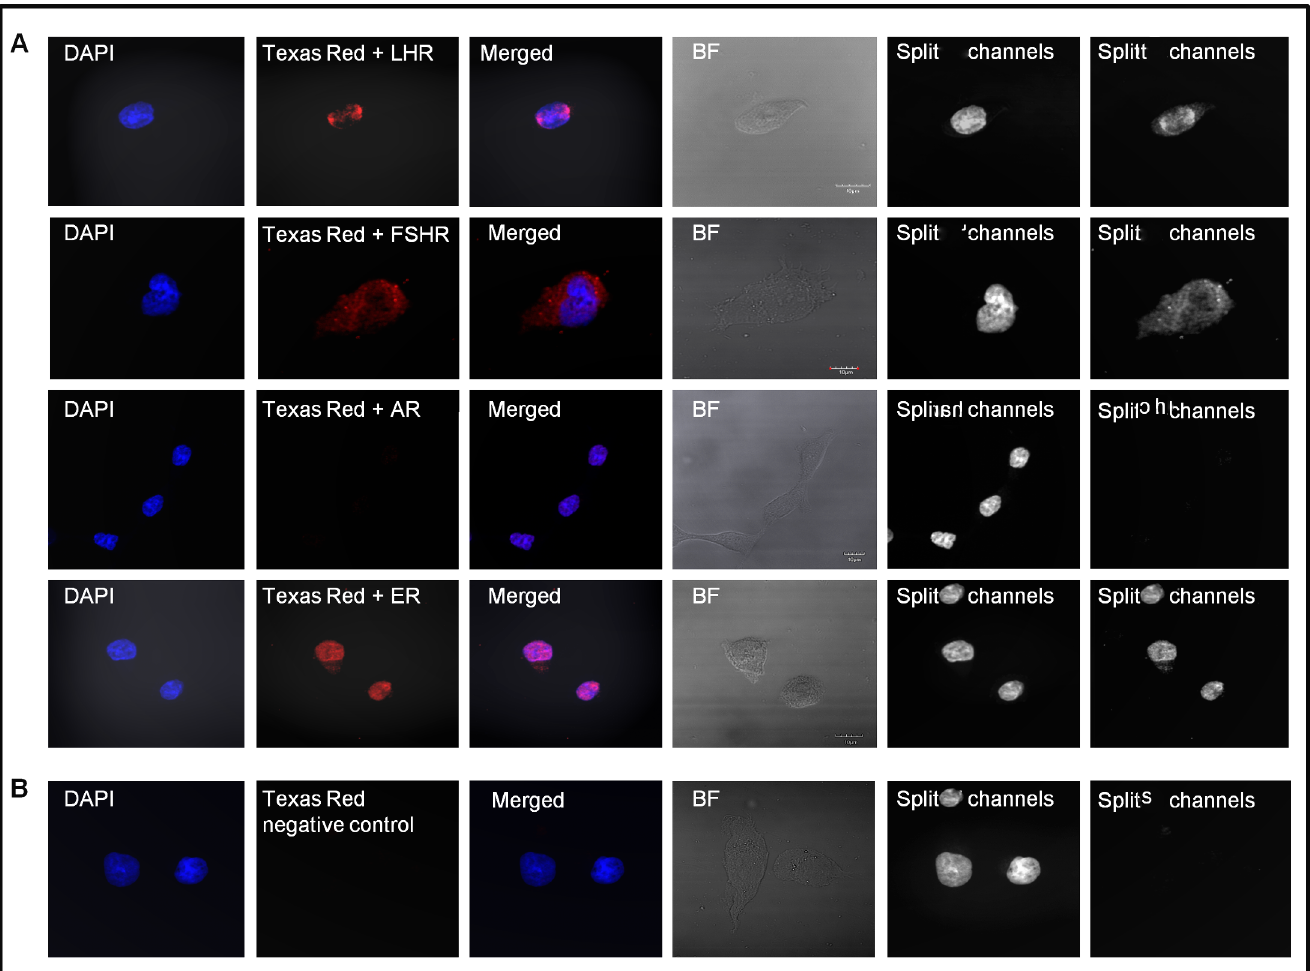
Fig 2. Human colon cancer cell line HTC116 expresses pituitary and gonadal glycoprotein receptors at the protein level. (A) Immunofluorescence staining of the transmembrane luteinizing hormone receptor (LH-R) and follicle-stimulating hormone receptor (FSH-R) and the nuclear androgen receptor (AR) and estrogen receptor (ER) in HTC116 cells. (B) Negative control. BF, bright field. Scale of merged picture, 10 μ M.